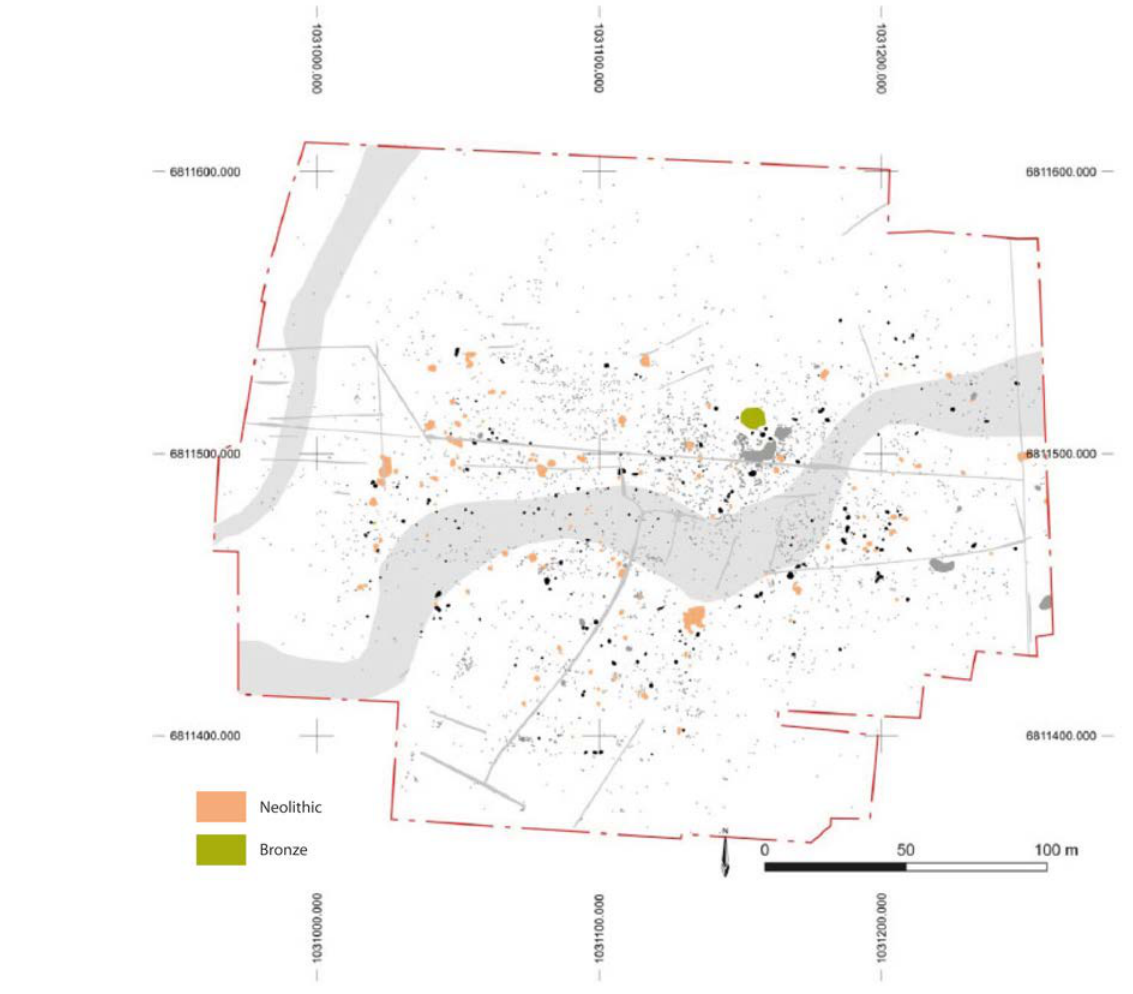
Figure 1. Map of the archaeological features of the Neolithic settlement of Dambach-la-Ville (Ch.